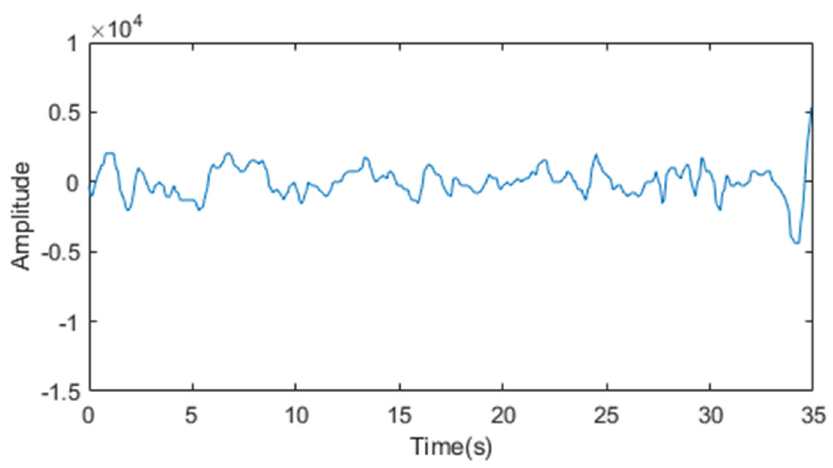
Figure 4. Tester’s signal when holding their breath.